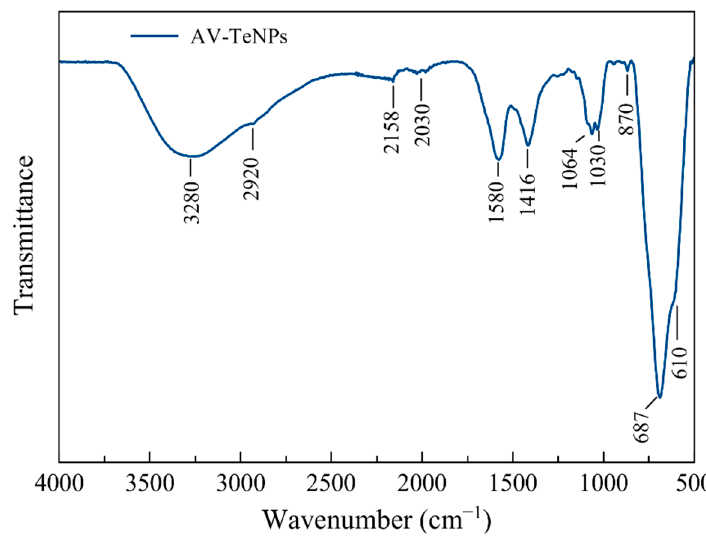
Figure 2. FT-IR spectrum of the aloe vera-mediated TeNPs (AV-TeNPs). Table 1. FT-IR main features of aloe vera-mediated tellurium nanoparticles (AV-TeNPs). which corresponds to the Si substrate onto which the sample (AV-TeNPs) was deposited. Wavenumber (cm − 1 ) Vibrational Modes The bands at 132 cm − 1 (E-bond stretching mode of Te) and 266 cm − 1 (related to